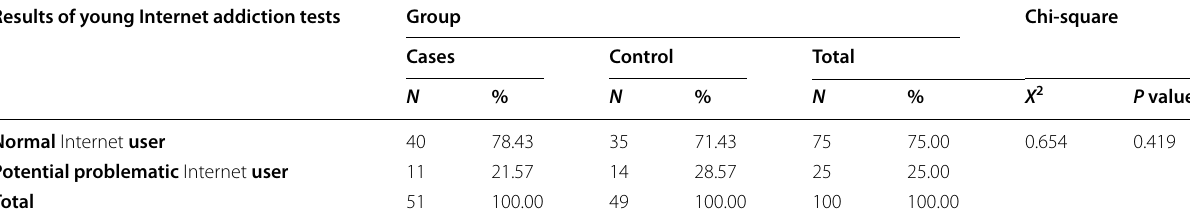
Table 4 Cases with sports addiction or at risk of Internet use Results of young Internet addiction